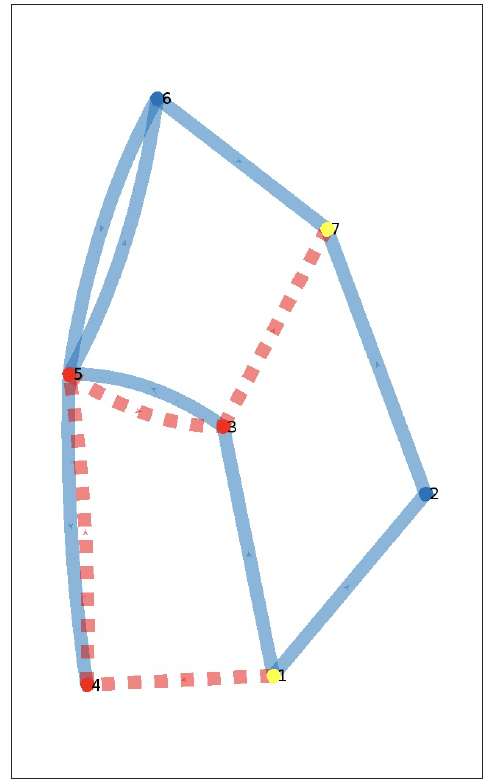
Figure 3. The optimal path (in red) corresponding to Case 1.